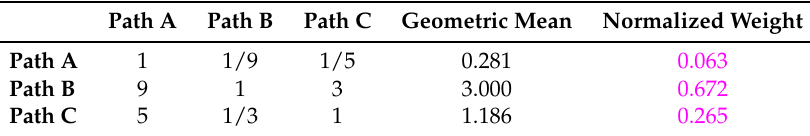
Table 6. Weight Evaluation for ‘Bumpiness’.